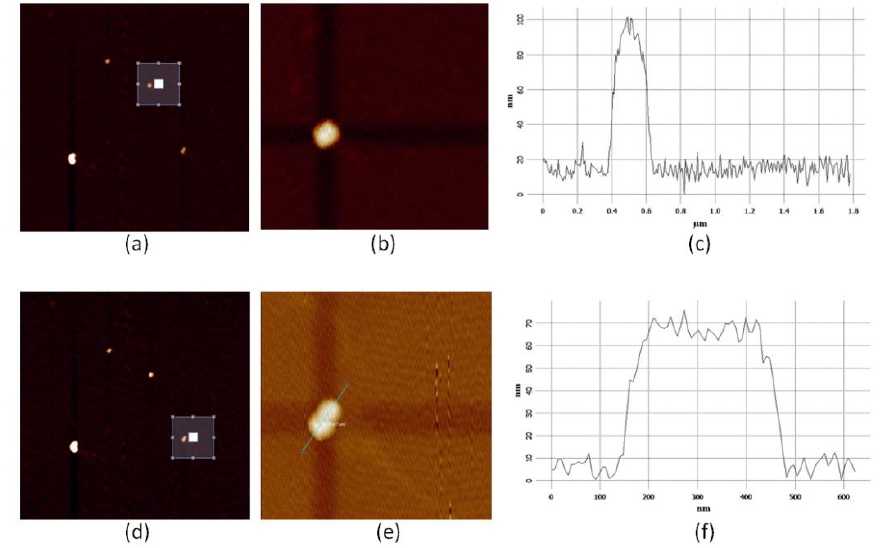
Figure 2. AFM images of two nanoparticle groups in the area as marked in Figure 1. ( a ) AFM image of the whole area of 9 µm × 9 µm where the small white line square indicates the subarea of 1.8 µm × 1.8 µm to be further scanned with higher resolution; ( b ) AFM image of the marked area in (a) where a single nanoparticle is enclosed; ( c ) height profile curve taken along the horizontal line in (b); ( d ) repeated AFM image for the whole area before scanning another subarea of 1.8 µm × 1.8 µm marked with the small white line square; ( e ) AFM image of the area marked in (d) where possibly a dimer structure is enclosed; ( f ) height profile curve taken along the possible dimer axis as marked in (e).